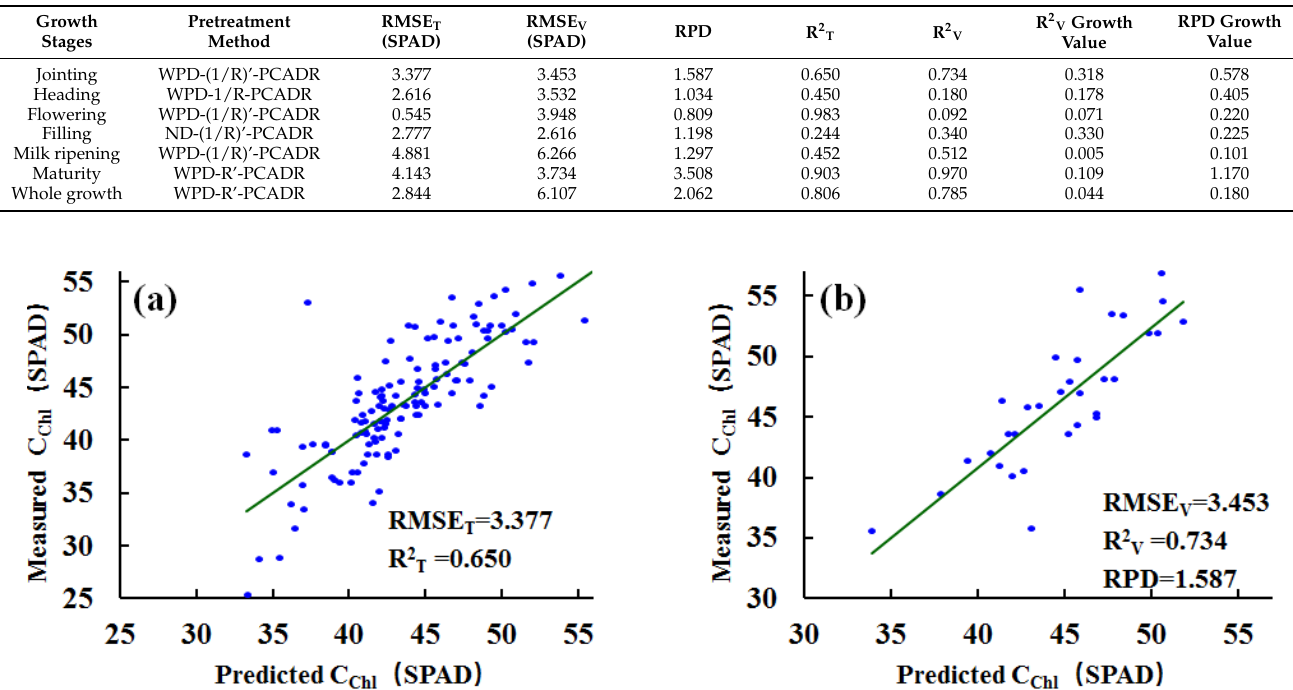
Figure 10. The estimated results of SPAD value for ( a ) training set and ( b ) validation set based on pretreatment WPD-(1/R)’-PCADR at jointing stage.